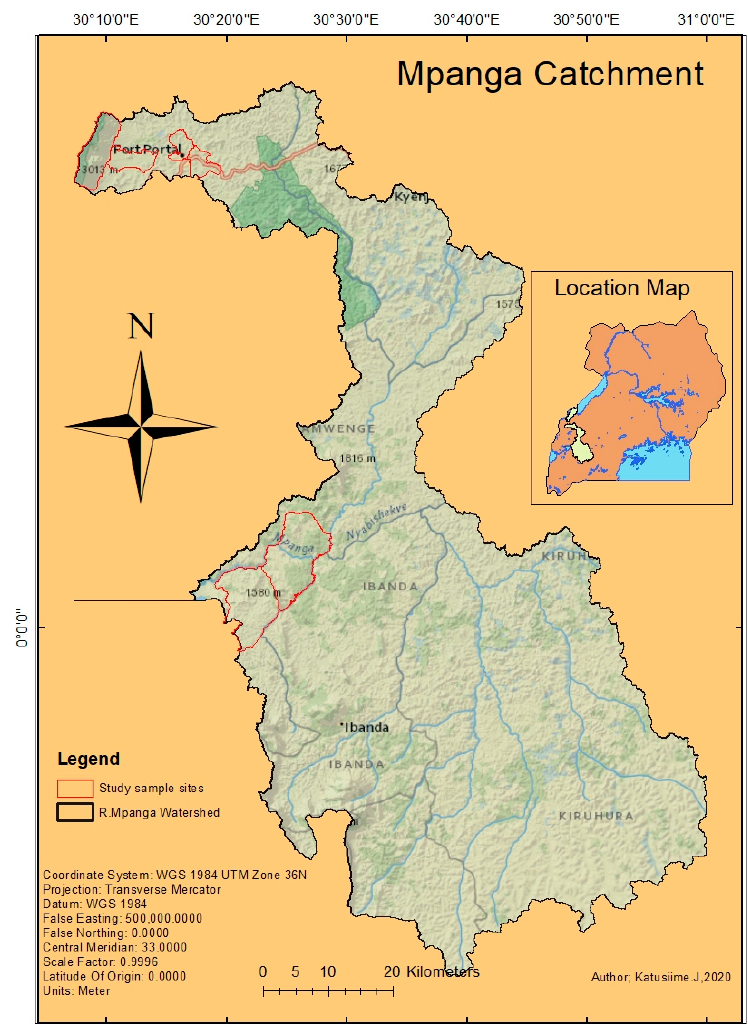
Figure 1. The study catchment Mpanga, highlighting the sample study sites. The catchment is exposed to integrated water resources management projects and measures.